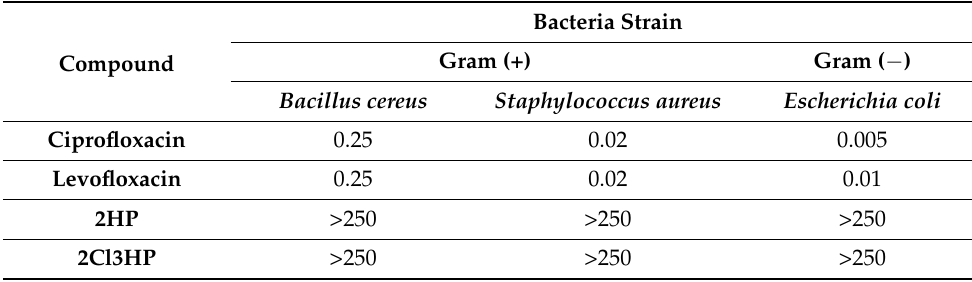
Table 5. The antibacterial activity of investigated compounds is defined as MIC [ µ M]. Ciprofloxacin and levofloxacin were used as references.